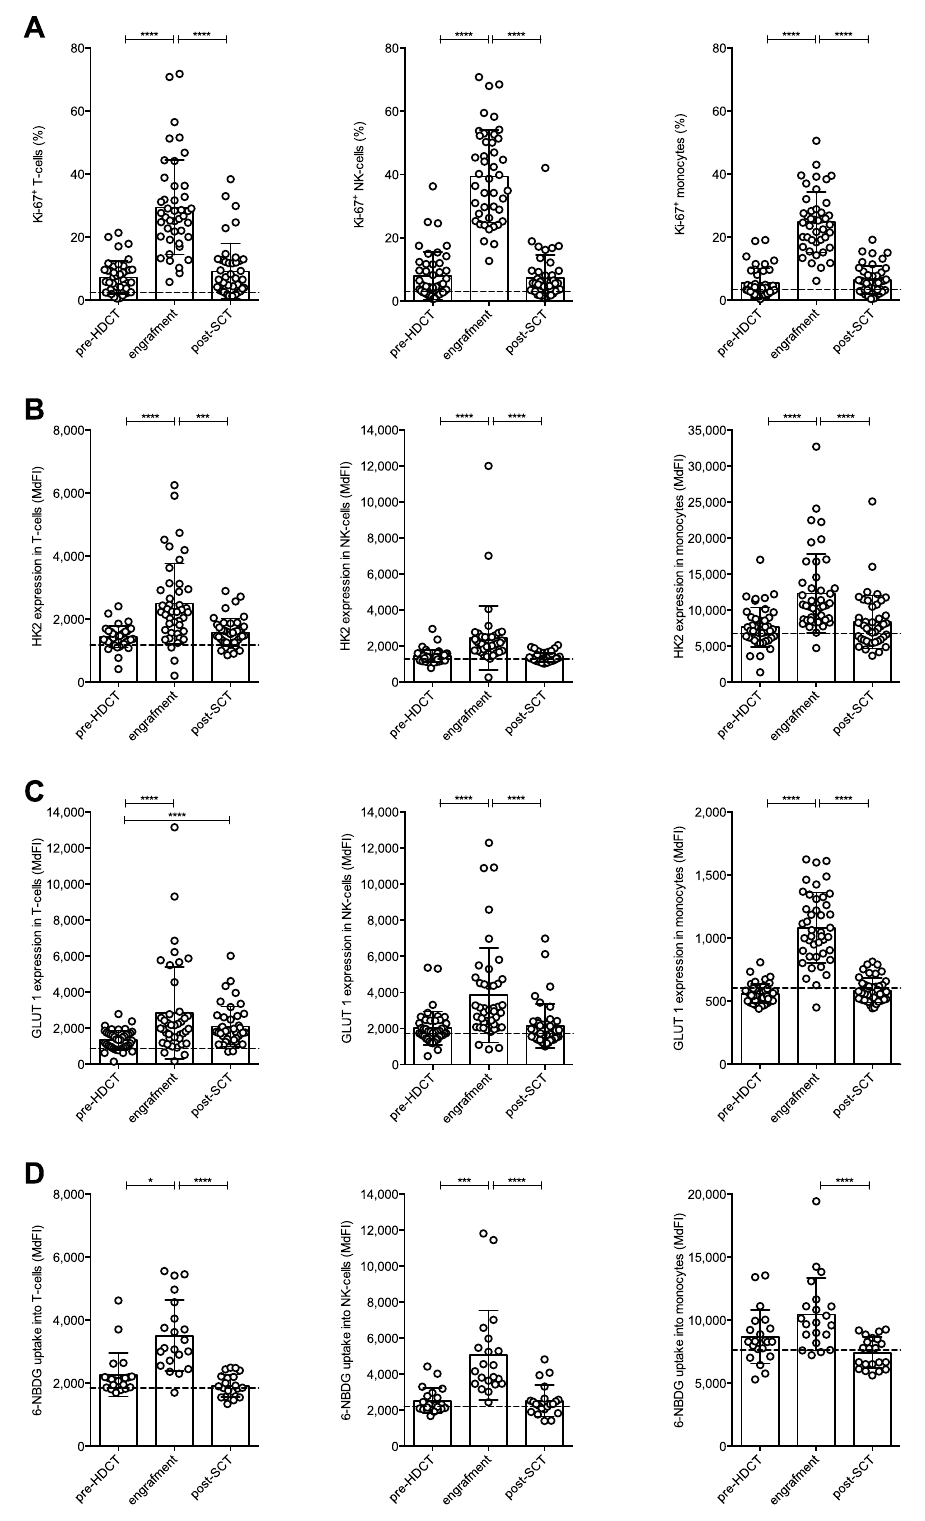
Figure 3. T-cells, NK-cells, and monocytes display increased proliferative activity and an enhanced glycolytic machinery during reconstitution upon HDCT/auto-SCT. ( A ) Proliferation is illustrated by plotting the percentages of Ki-67 + cells during all three time points. ( B ) The expression of the rate-limiting enzyme of glycolysis hexokinase 2 (HK2) was measured. ( C ) The abundance of the glucose transporter GLUT1 was evaluated. ( D ) To measure the cells’ glucose uptake the fluorescent glucose analogue 6-NDBG was used and plotted as median fluorescence intensity (MdFI) for all cell populations (n: 43, for Ki-67, HK2 and GLUT1, n: 21 for 6-NBDG; mean values +/− SD). The mean of a healthy donor control group (n: 20 for Ki-67, HK2 and GLUT1, n: 10 for 6-NBDG) is shown as a horizontal dashed line for reference. Statistical significance was determined using a Friedman test with Dunn’s multiple comparison tests for repeated measurements. *P < .05; ***P < .001; ****P <